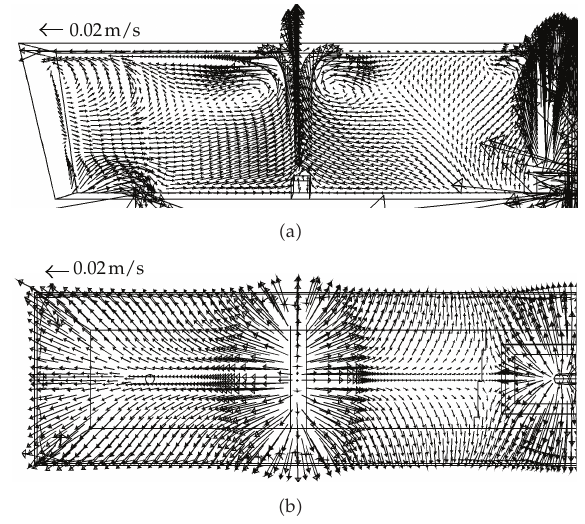
Figure 8: Velocity profiles inside the tundish with argon injection, (cid:4) a (cid:5) At the symmetric-longitudinal plane and (cid:4) b (cid:5) At the tundish steel